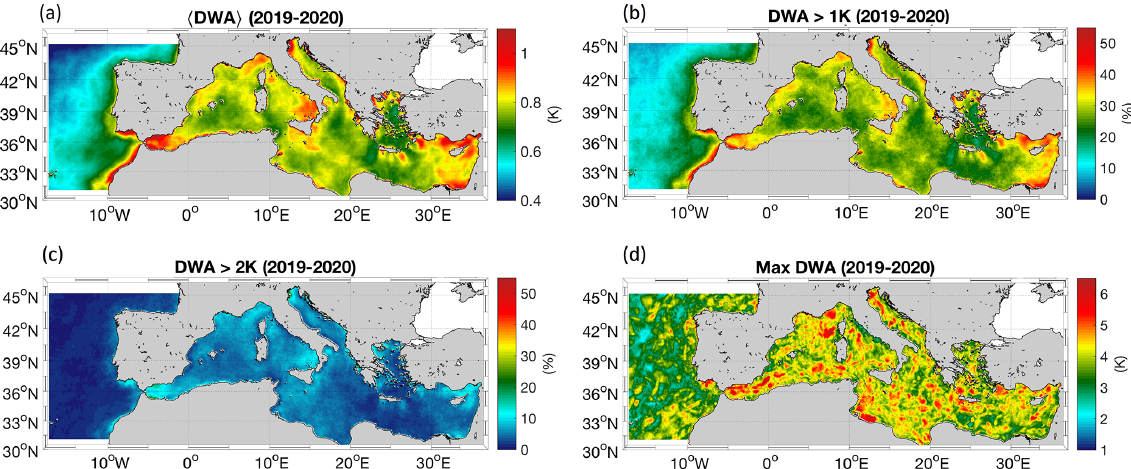
Figure 8. (a) Mean diurnal warming amplitude (DWA) derived from DOISST. (b) Percentage (over the total number of days in the 2019– 2020 period) of DOISST DWA larger than 1K. (c) Percentage of DOISST DWA larger than 2K. (d) Maximum observed DOISST DWA. All